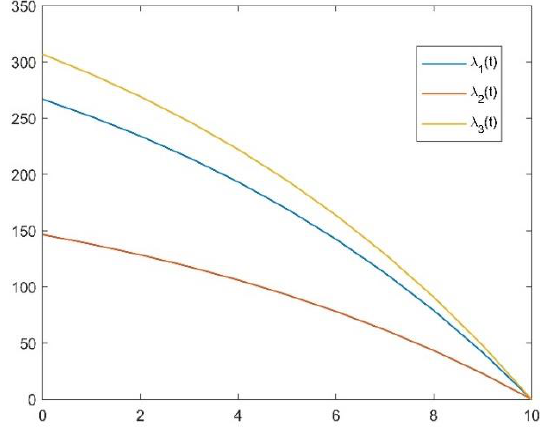
Figure 2. Adjoint variable trajectories over time.